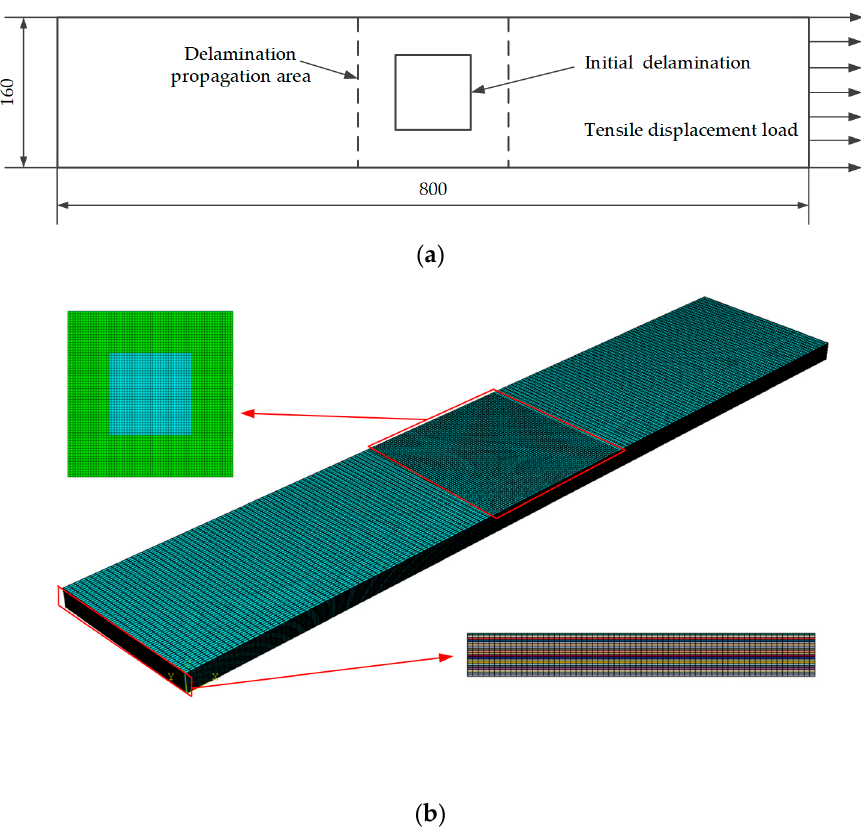
Figure 13. The geometric configuration and mesh division of the model: ( a ) geometric distribution of the model; ( b ) local meshing of the model. Table 6. Initial delamination design and failure strength.